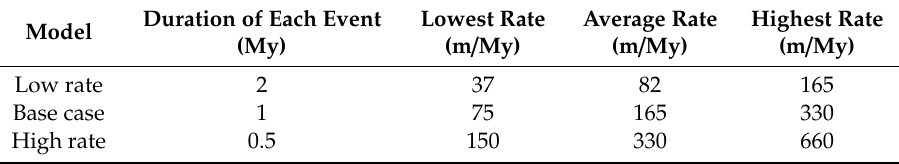
Table 1. Values of sedimentation rate in the models